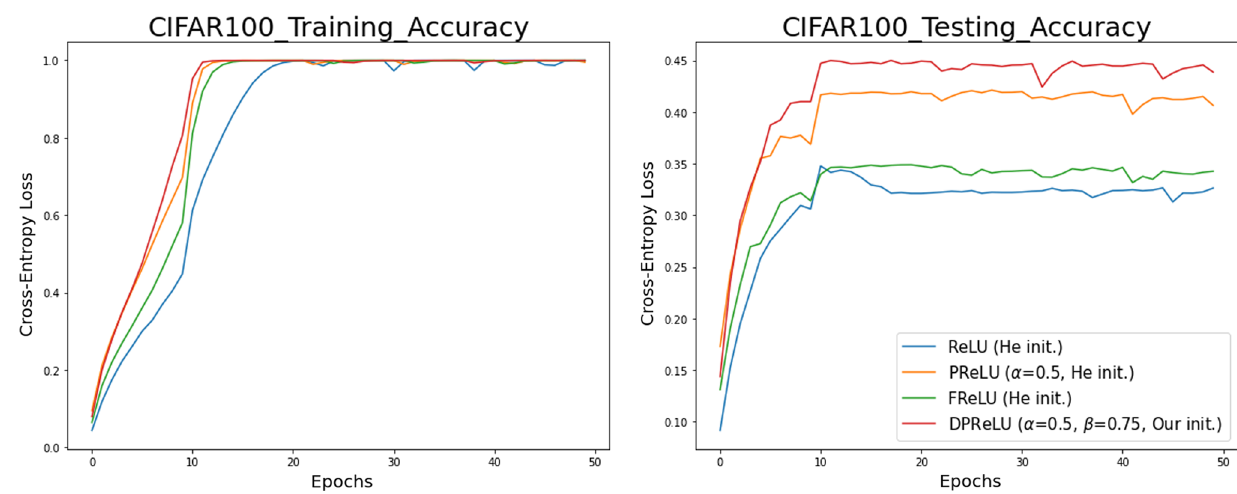
Fig. 7 Training and testing accuracies of the ResNet50 models using each activation with corresponding weight initialization on the CIFAR-100 dataset. (0th epoch ∼ 50th epoch) ( 𝛼 and 𝛽 represent the